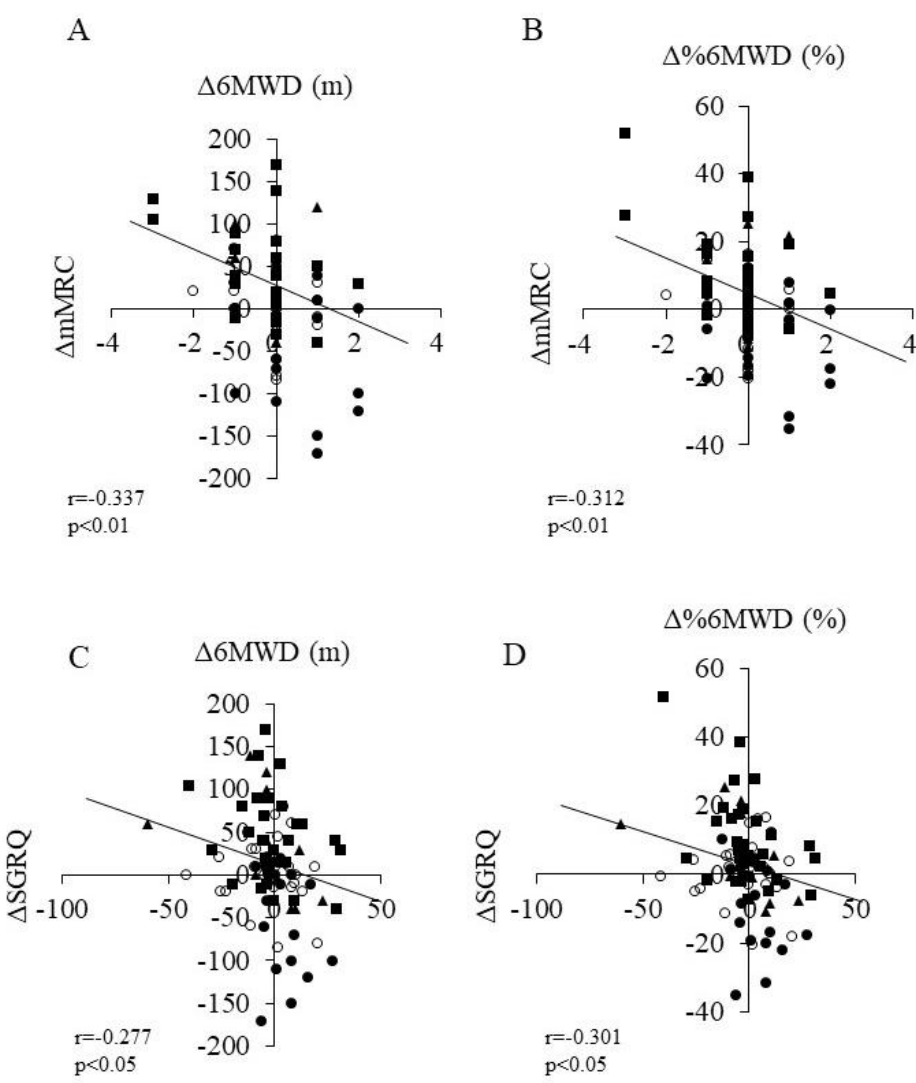
Figure 3. Relationship between ( A ) Δ6MWD and ΔmMRC scale scores, ( B ) Δ%6MWD and ΔmMRC scale scores, ( C ) Δ6MWD and ΔSGRQ scores, and ( D ) Δ%6MWD and ΔSGRQ scores in all patients. ○ : control group, ■ : PR group, ● : AFD group, ▲ : PR+AFD group. Abbreviations: AFD, antifibrotic drugs; PR, pulmonary rehabilitation; Δ, delta; 6MWD, six -minute walk distance; mMRC, modified Medical Research Council; SGRQ, St George Respiratory Questionnaire.